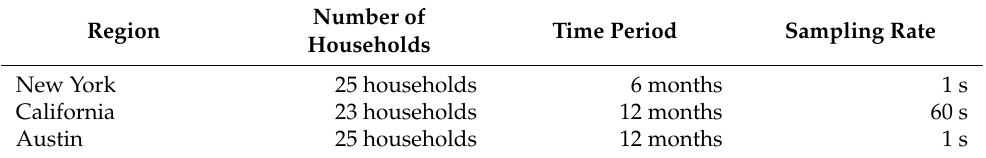
Table 1. Overview of the parts of the Pecan Street dataset with electric vehicles and photovoltaic systems. Number of Region Time Period Sampling Rate Households New York 25 households 6 months 1 s California 23 households 60 s Austin 25 households 12 months 1